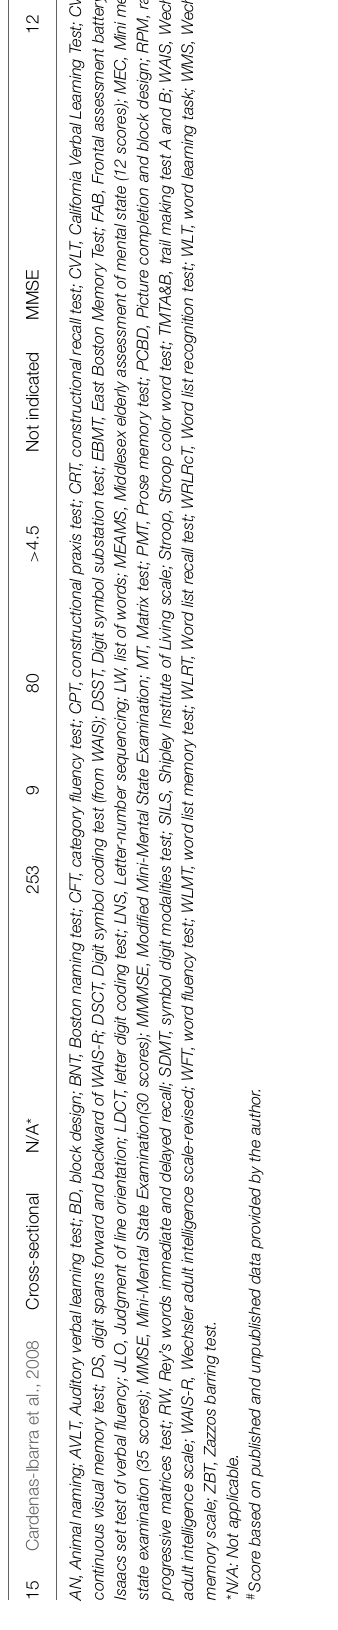
TABLE 3 | Cognitive tests and domains used for